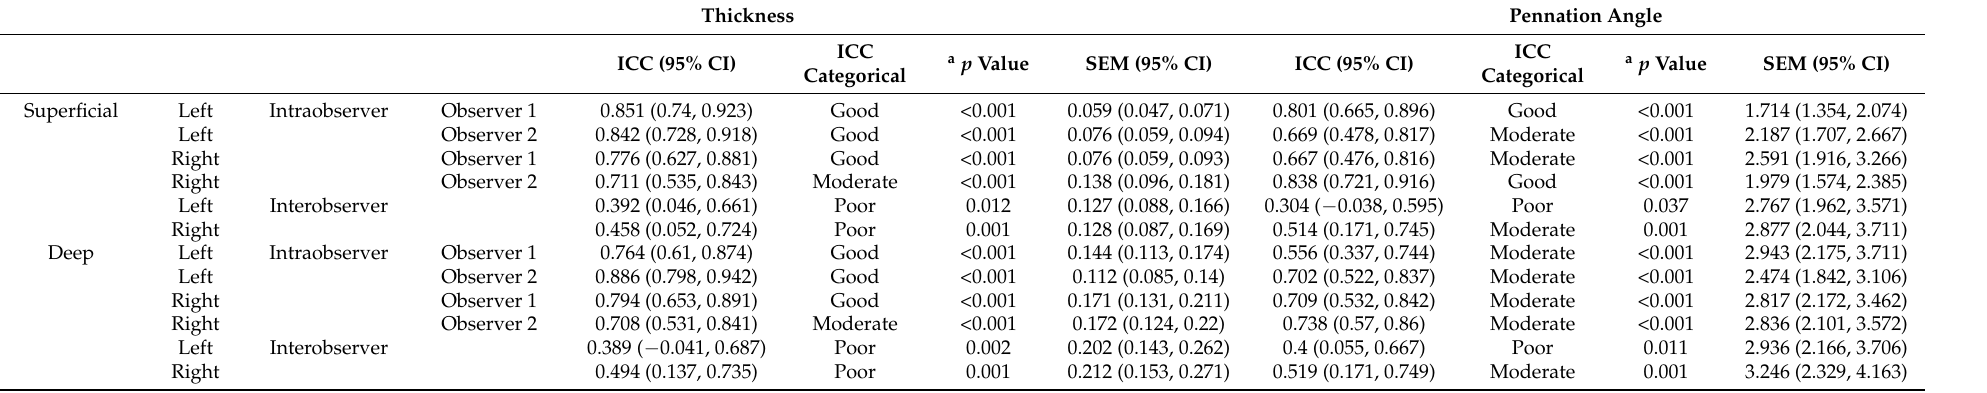
Table 3. Intraclass correlation coefficient